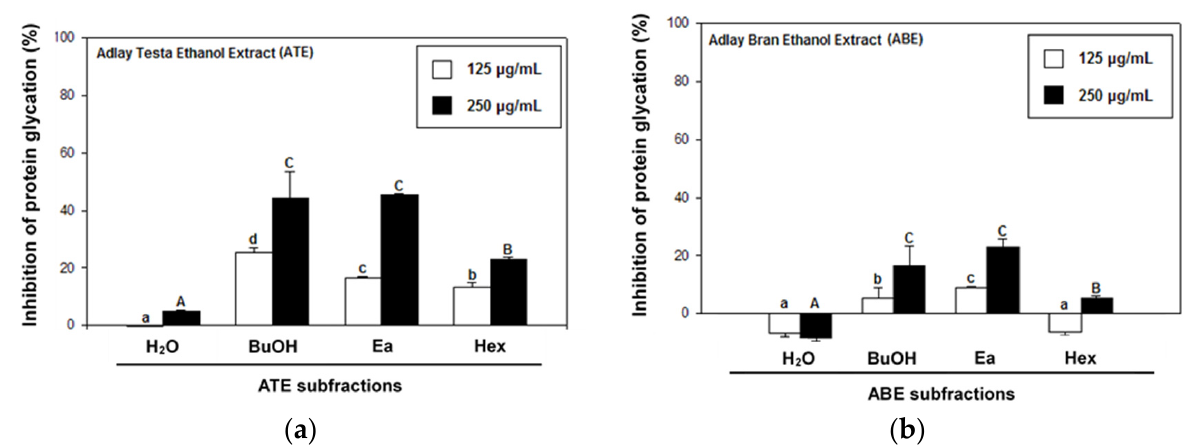
Figure 3. Effects of different solvent fractions of ATE ( a ) and ABE ( b ) on glucose-mediated devel- opment of fluorescence of AGEs (BSA-glucose assay). Groups with different letter superscripts are significantly different ( p < 0.05). a–c, treated with 125 µ g/mL; A–C, treated with 250 µ g/mL.